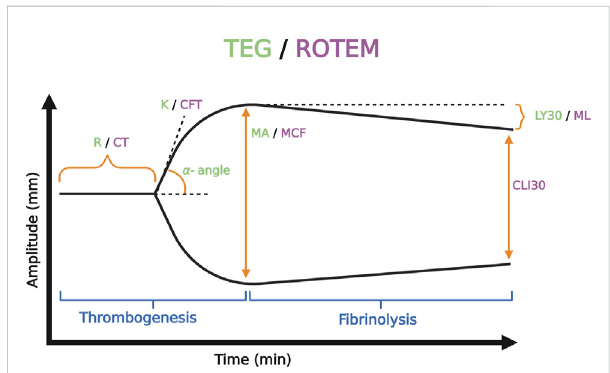
FIGURE 6 Representative Normocoagulable Thromboelastography (TEG) and Rotational Thromboelastometry (ROTEM) Tracing with Their Respective Parameters De fi ned. TEG and ROTEM parameters are represented by green and purple text, respectively. The time for the clot to reach 2 mm amplitude on the y -axis describes the reaction time (R) for TEG and clotting time (CT) for ROTEM. R and CT correlate to the activated partial thromboplastin time (aPTT) and prothrombin time (PT). The time spanned from 2 to 20 mm amplitude is called the kinetics (K) for TEG and the clot formation time (CFT) for ROTEM; these represent the speed of fi brin buildup. Likewise, alpha-angle measures the rate of fi brin buildup. The maximum amplitude (MA) on TEG and the maximum clot fi rmness (MCF) on ROTEM re fl ect crosslinking of fi brin with platelets and correspond to maximum clot retraction strength. Measurements of fi brinolysis include lysis at 30/ 60 min(LY30/60)whichisthepercentagedecreasefromMAachieved at 30/60 min, clot lysis index at 30/60 min (CLI30/60) which is the percentage of clot amplitude remaining relative to the MCF at 30/ 60 min, and maximum lysis (ML) which is the percentage decrease in MCF at a given length of time (Görlinger et al., 2021; Hartmann and Sikorski, 2021; Volod et al., 2022). Created with BioRender.com.